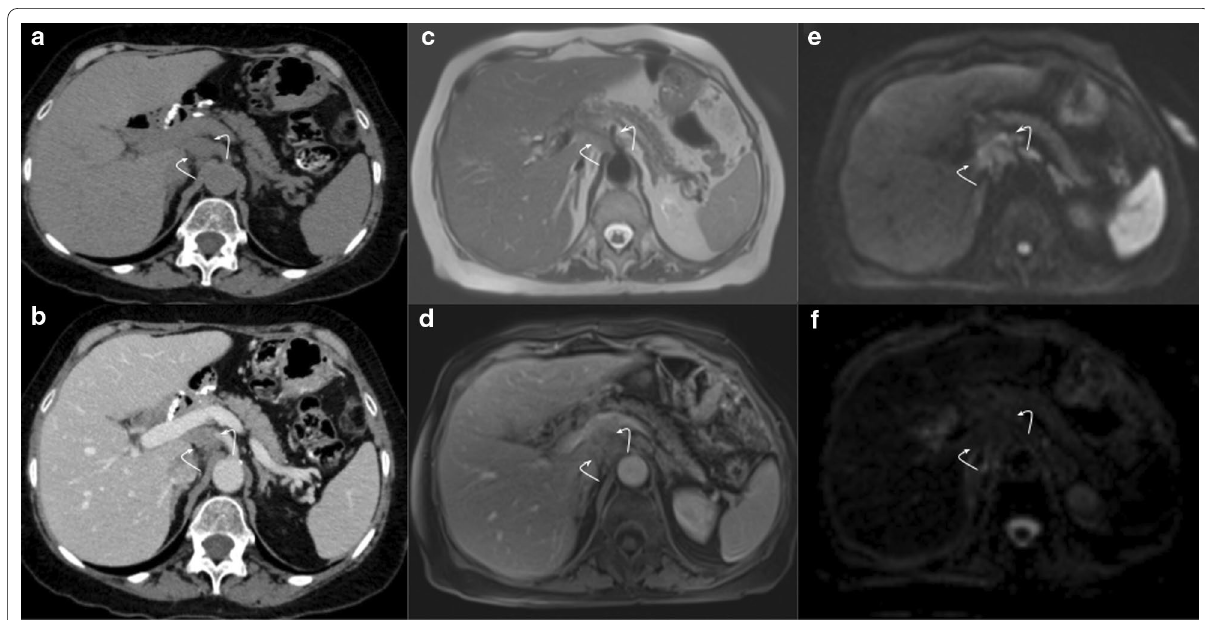
Fig. 13 Tumor recurrence. DWI value. 69-year-old female patient during routine follow-up after pancreaticoduodenectomy due to pancreatic adenocarcinoma. ( a , b ) Non-contrast and portal venous phase CT scan, respectively. Shows an ill-defined soft tissue enhancing image in the surgical bed (curved arrows). ( c , d , e , f ) Six month later MRI control. Persistent image surrounding the celiac trunk with no significant progression (curved arrows in c and d ). DWI ( e ) and ADC map ( f ) shows restriction, raising local recurrence diagnosis (curved arrows in e and f ). The patient evolved unfavorably with disease progression